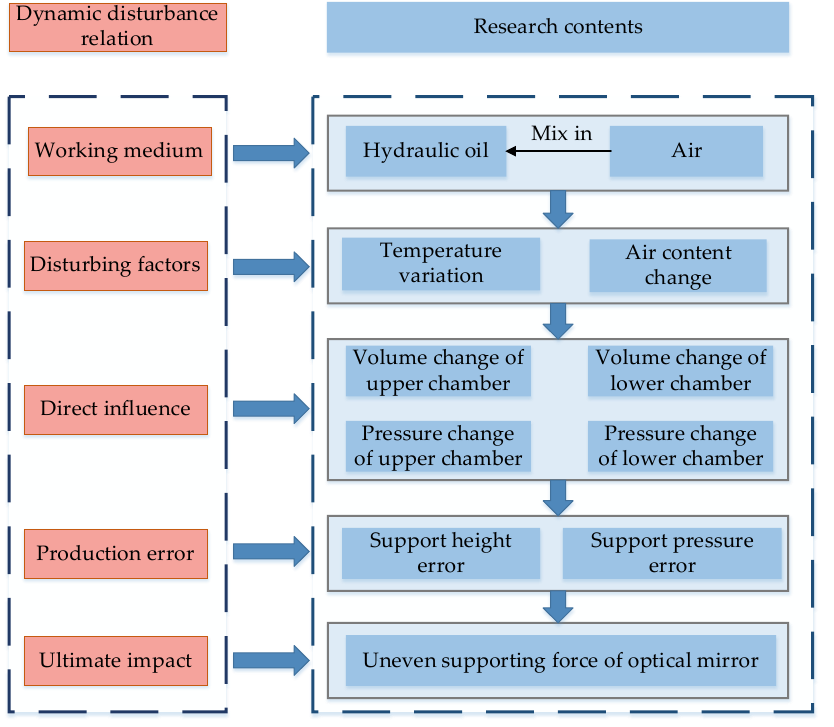
Figure 3. Perturbation affecting relationship.